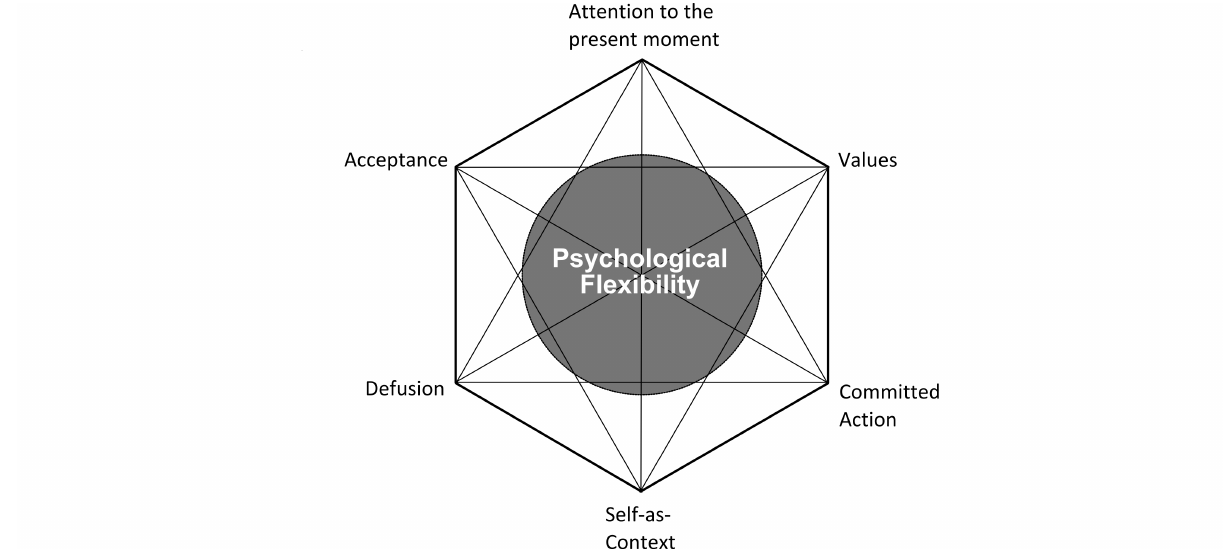
Figure 1. The ACT hexaflex with the 6 core